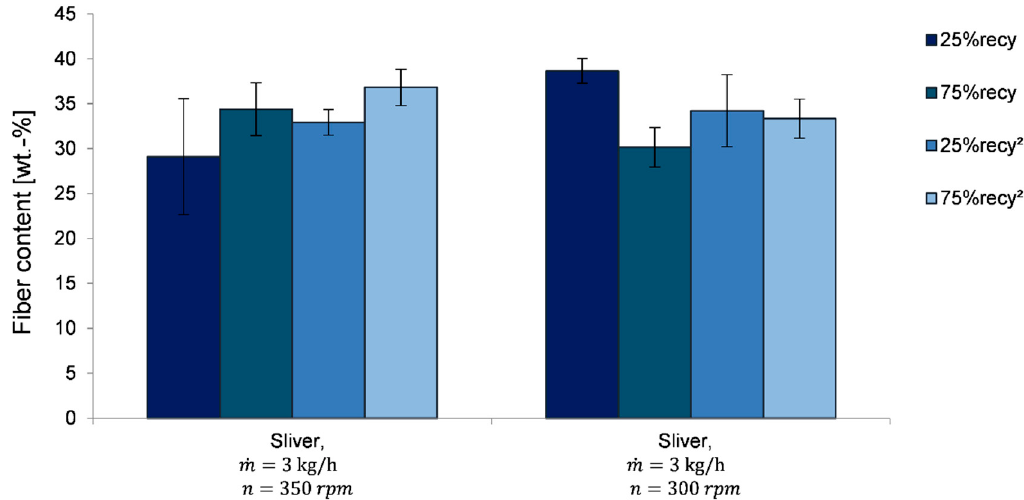
Figure 10. Averaged fiber content of the recycled staple fiber sliver with varying recycling content of the matrix.